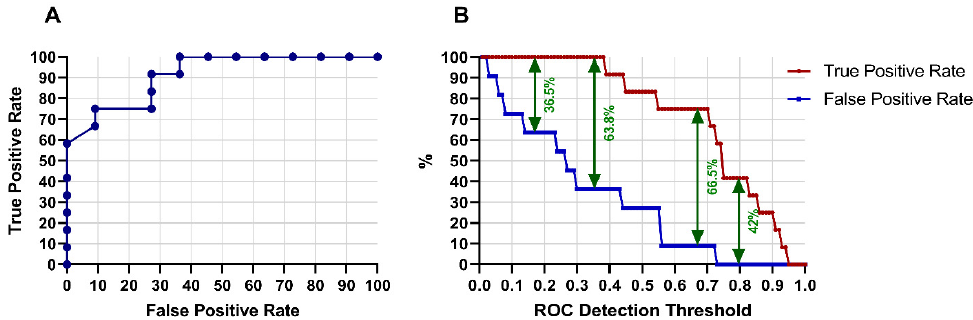
Figure 2. ( A ): Illustrates receiver operating characteristic (ROC curve) and accuracies through thresholds after 100 training iterations improvements. For the testing sets, with pedestrial / non-pedestrial threshold = 1, RBF neural network predicts correctly 91%. ( B ): Comparison between the true and false positive prediction